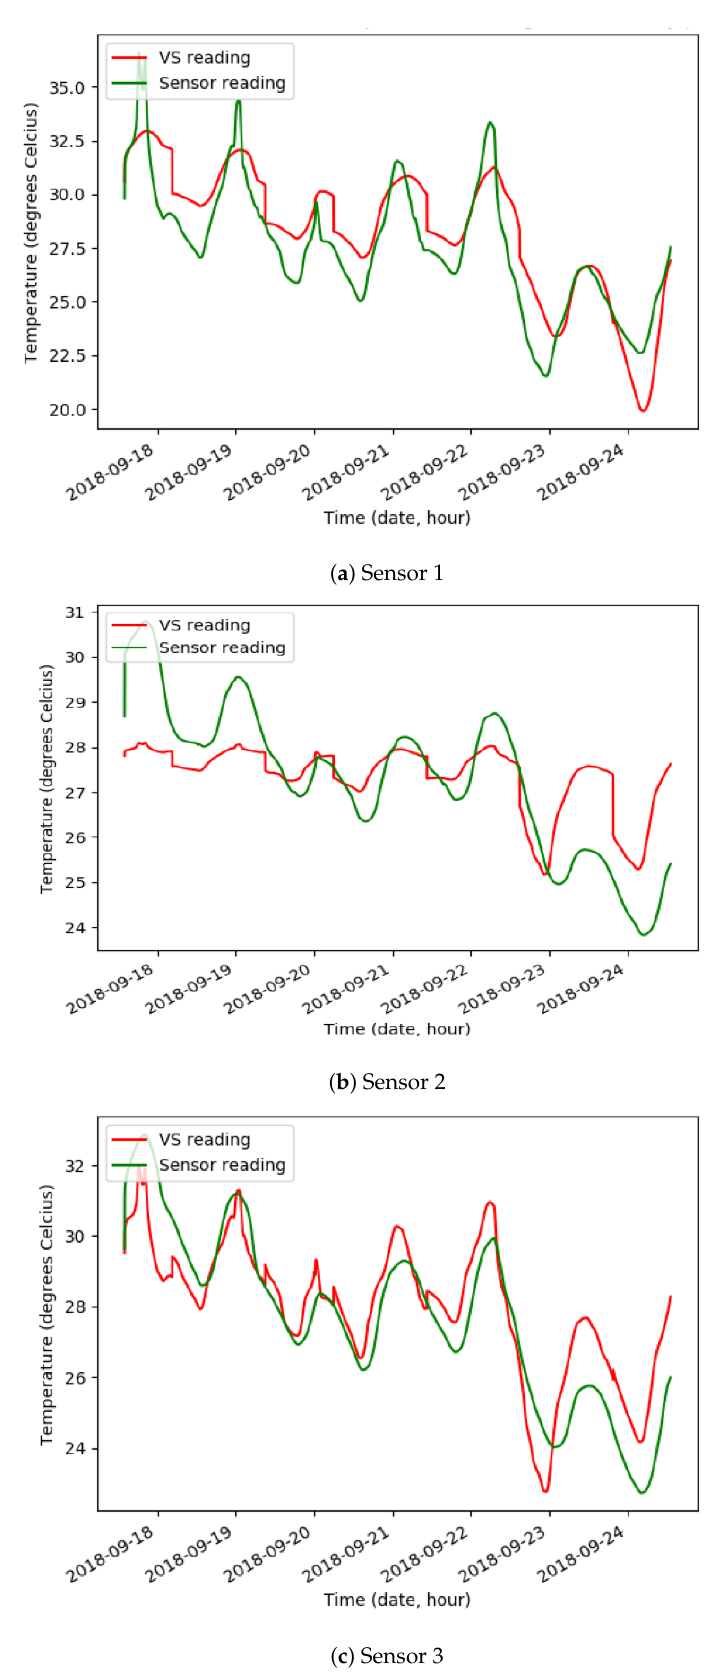
Figure 9. Virtual Sensor Readings in large residential building.